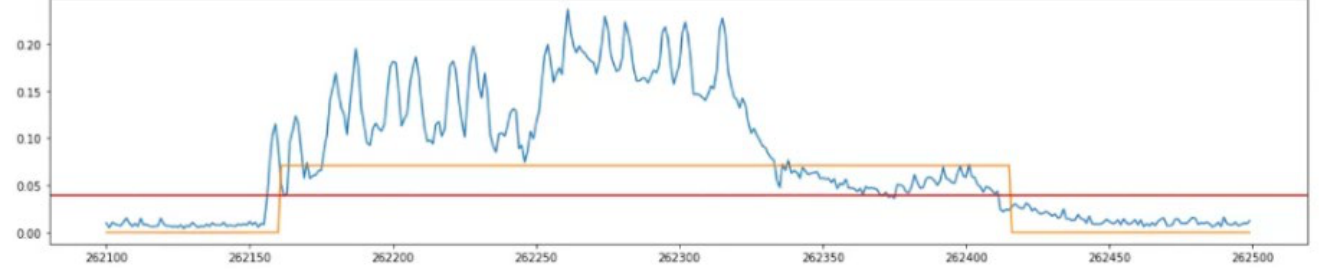
Figure 14. Section 5: 262,100~262,500 (Attack 33). The red line is the threshold, and when the blue line crosses the red line, we predict an attack. The orange line is the actual attack range.